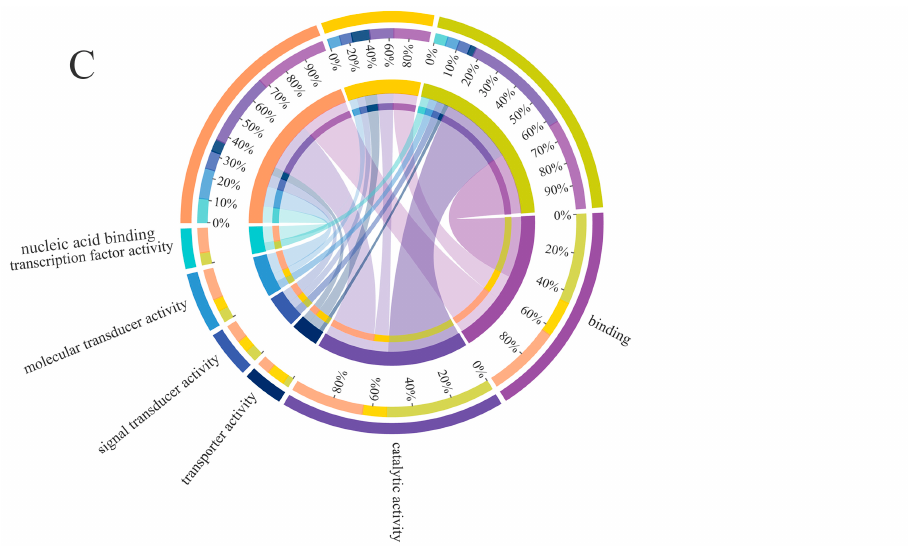
Figure 5. GO terms annotated by the target DEmRNAs in the three comparison groups: ( A ) the annotated terms regarding biological processes; ( B ) the annotated terms regarding cellular components; ( C ) the annotated terms regarding molecular functions. Different colors represent different GO terms. The percentages indicate the proportions of the source genes annotated to the same GO term in all source genes targeted by DEcircRNAs in every comparison groups.